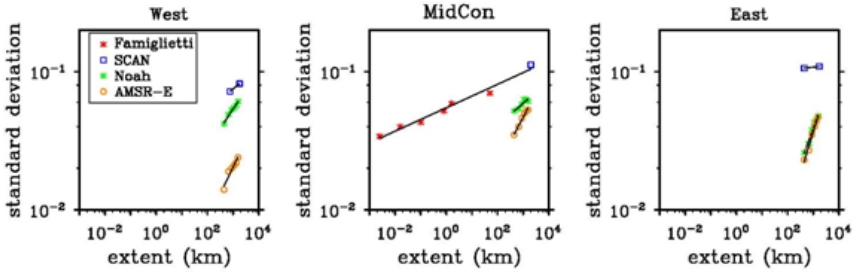
Fig. 9. Log-(standard deviation of soil moisture) as a function of log-(extent) in climate regions. Standard deviations of SCAN, Noah and AMSR-E soil moisture were obtained by temporally averaging daily values in each region over the 198 days.